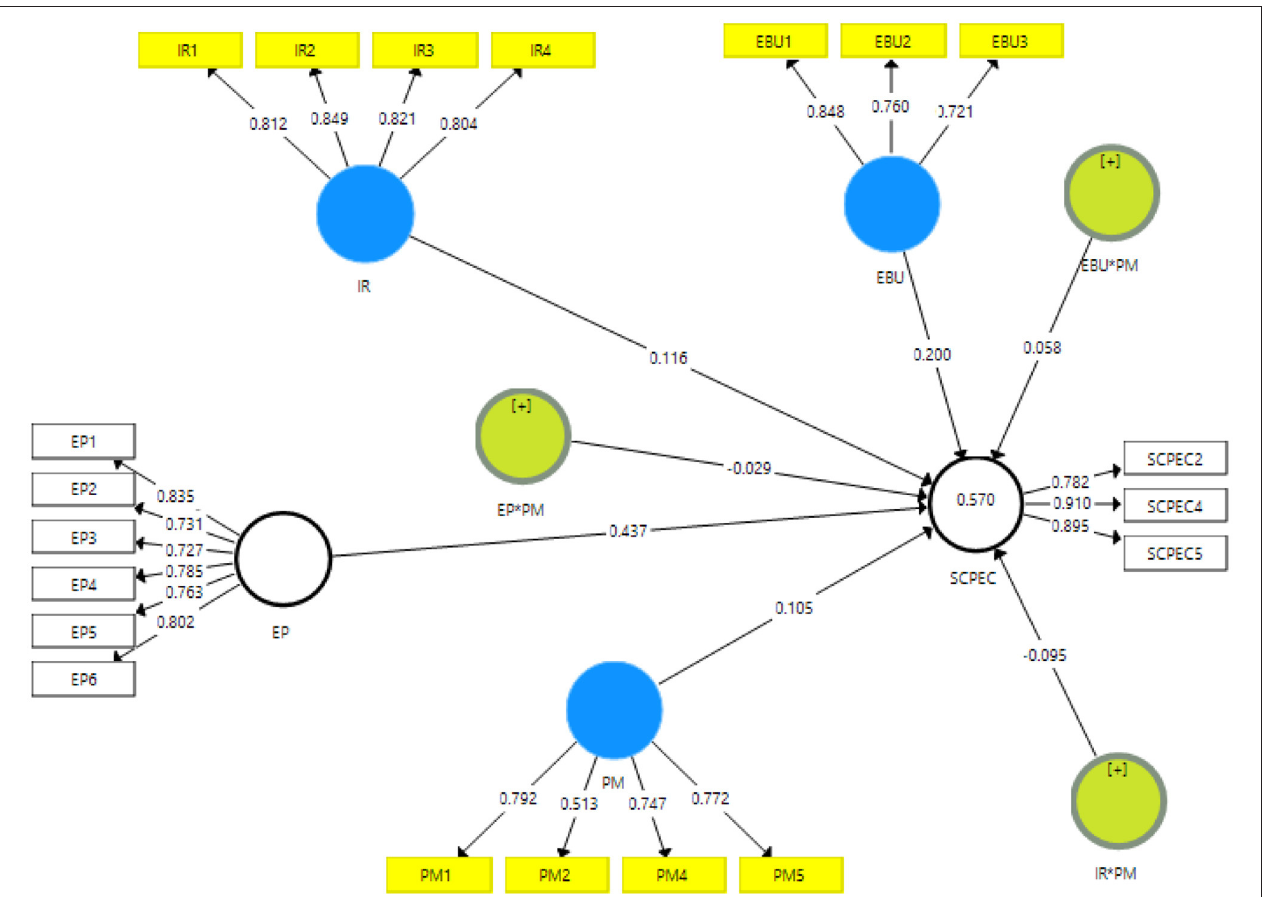
FIGURE 3 | Measurement model